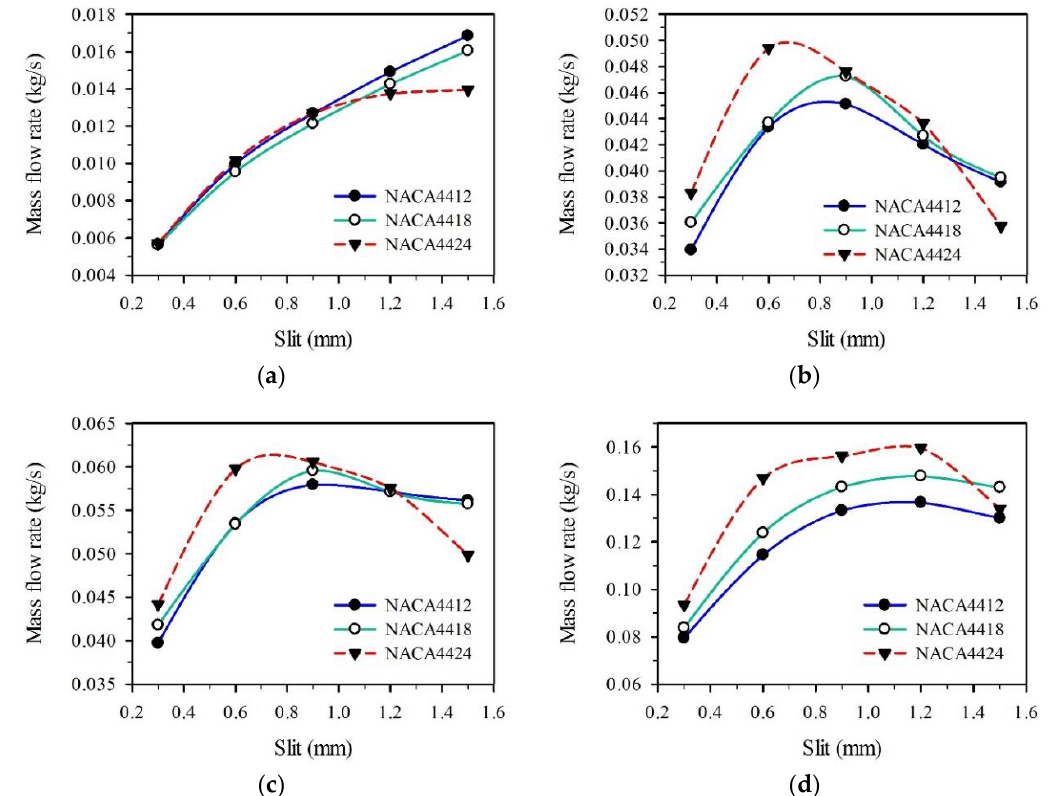
Figure 12. Mass flow rate ( a ) at the inlet of Plane S, ( b ) on Plane M1, ( c ) at the outlet of Plane M2, and ( d ) at the outlet of Plane M3 in relation to the slit sizes of the NACA4412, NACA4418, and NACA4424 airfoils.